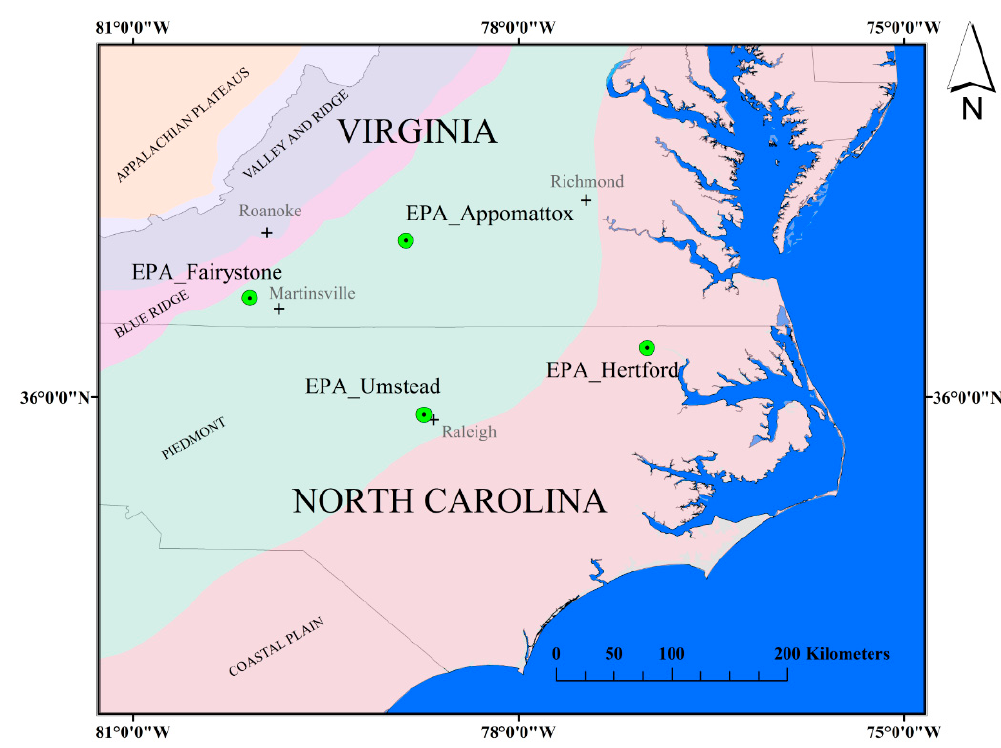
Figure 1. Virginia and North Carolina (USA) leaf area index (LAI) research sites. Table 1. Location, region, and tree species distribution over four 1 km LAI research sites.